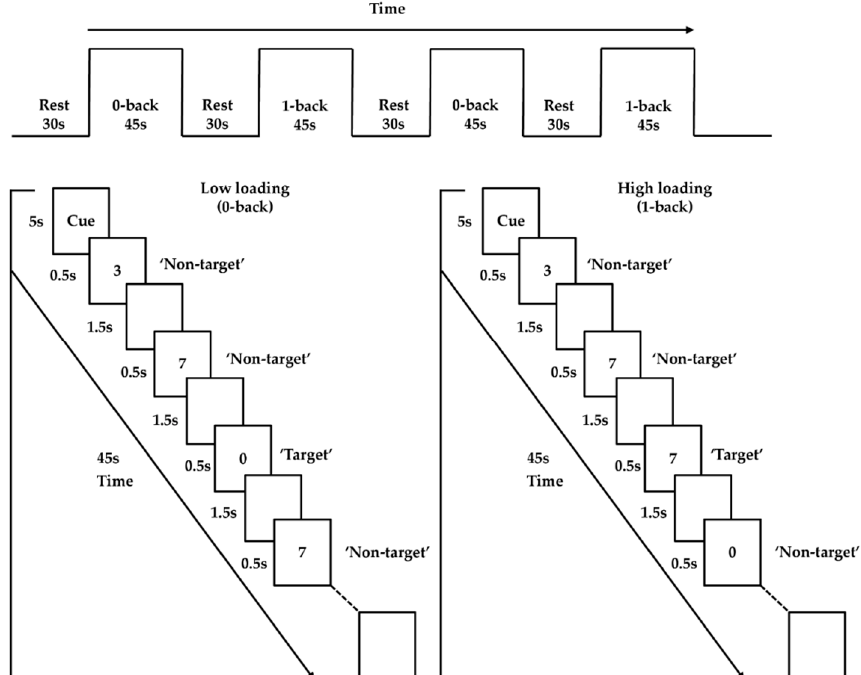
Figure 1. n -back task paradigm.